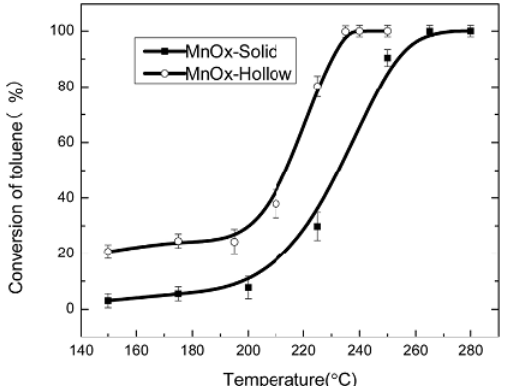
Figure 17. Toluene conversion over MnO x catalysts. Reaction conditions: catalysts weight = 0.3 g, toluene concentration = 1000 ppm, WHSV = 32,000 mL g − 1 h − 1 . Reprinted with permission from Ref.